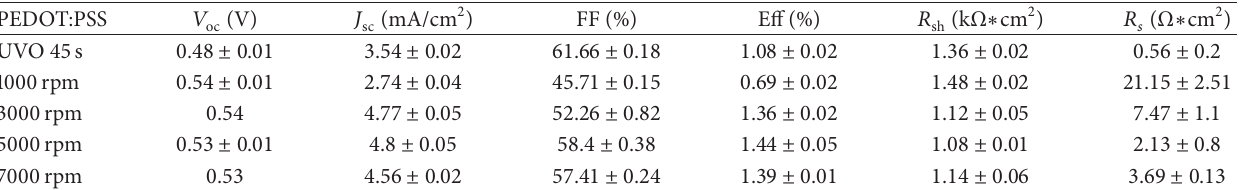
Table 1: Photovoltaic characteristics of TOPVs with various PEDOT:PSS thin films on Ag-AgO 𝑥 anode.